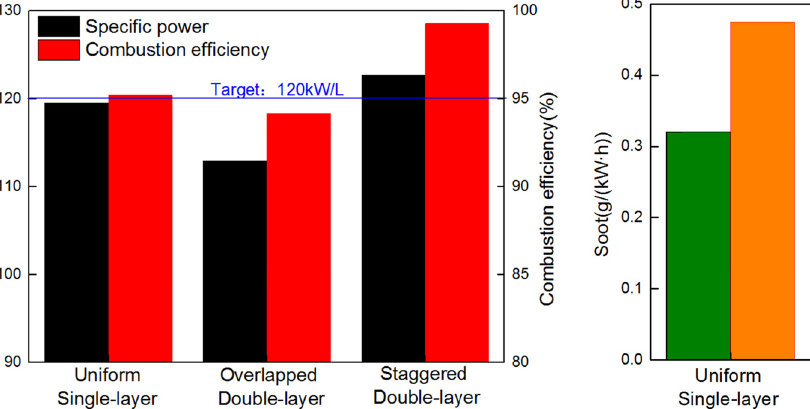
Figure 23: Soot and NOx emissions for di ff erent arrangements of nozzle holes.